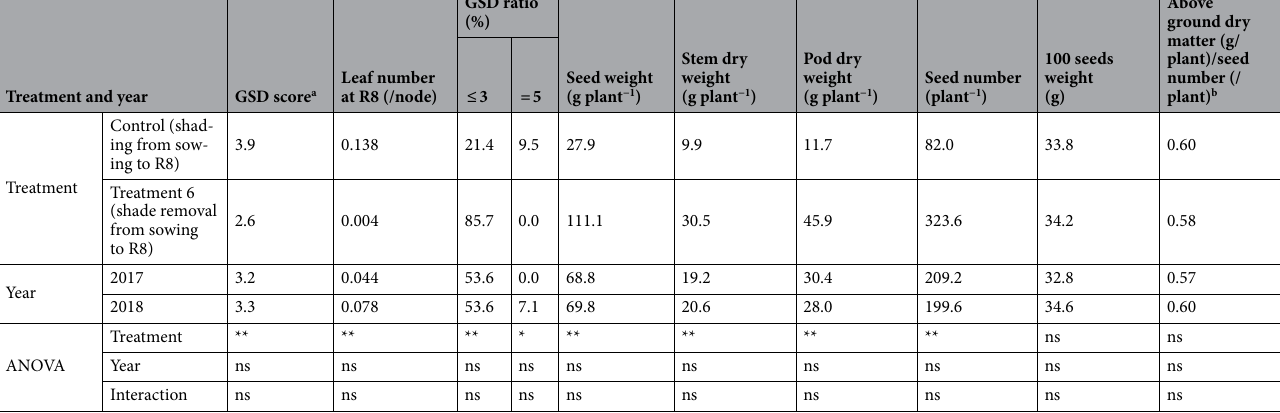
Table 1. Effects of shading throughout the cultivation period on GSD severity in experiment 1. **Significantly different ( p < 0.01). *Significantly different ( p < 0.05). ns: nonsignificant ( p < 0.05). a ANOVA was conducted after Box-Cox transformation. b Above ground dry matter (g/plant) means the sum of seed weight